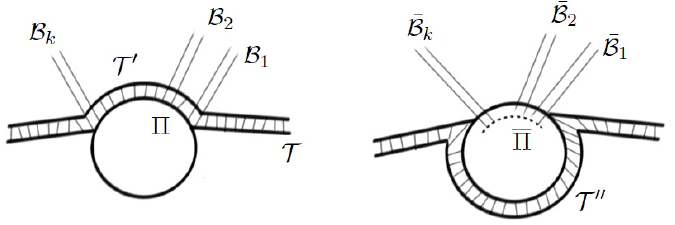
Fig. 12. The band moving transformation of a θ -band and a